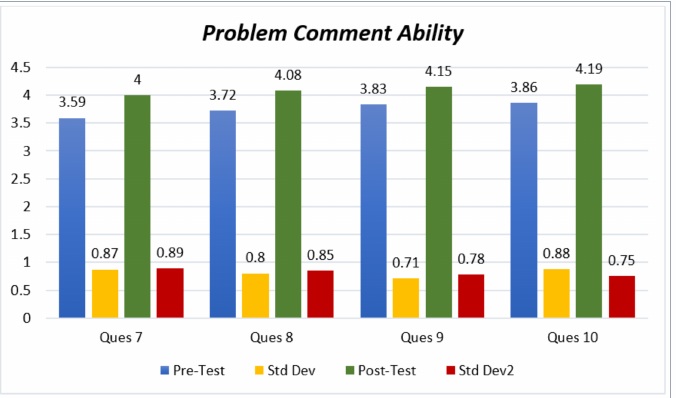
Figure 10. Students’ problem comment ability in the previous test and the post-test.